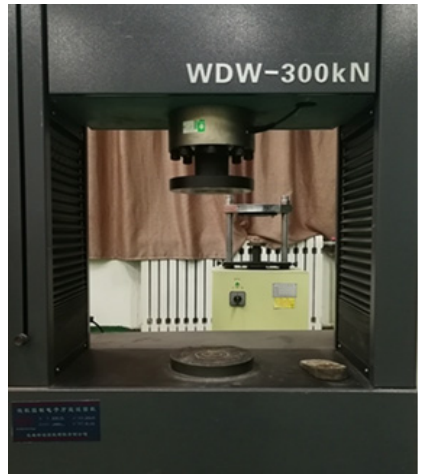
Figure 5. Electronic universal testing